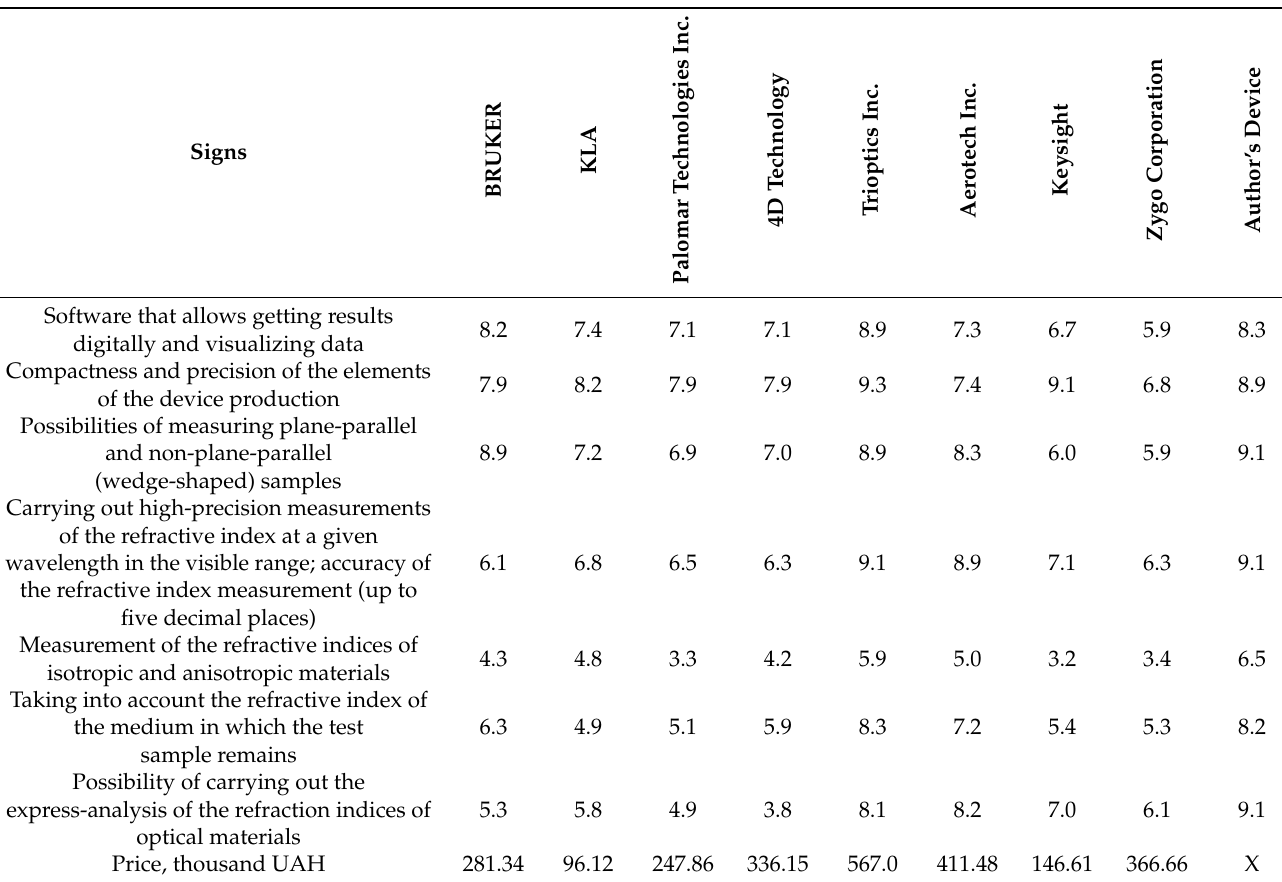
Table 6. Results of the evaluation and market prices for competitive analogues of the device for the interferometric determination of the refractive index of crystalline materials in the optical range (enterprises in Europe and other regions of the world) 1